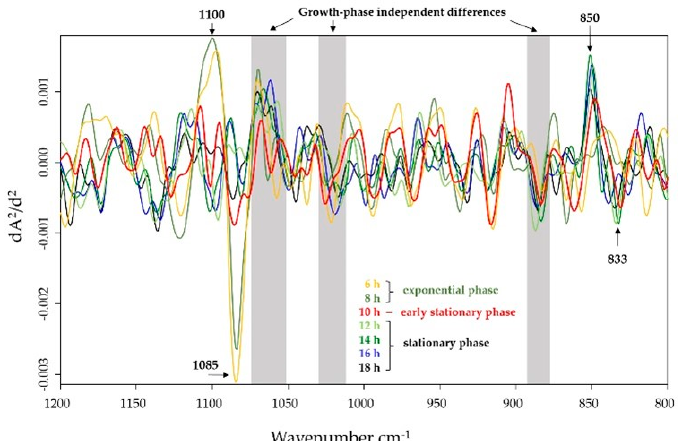
Figure 2. Differences between IN and HA surface-associated glycopolymer expression were exam- ined by FTIR spectroscopy. Alteration in the expression of S. aureus surface-associated glycopolymers of IN and HA was monitored between 6 and 18 h by 2 h intervals. Spectral comparison of bacteria at different time points was performed using the polysaccharide spectral region (1200–800 cm − 1 ), dominated by vibrations of various carbohydrates and their specific types of glycosidic linkages. Subtraction spectra were generated from the second derivative, vector-normalised, average S. aureus FTIR spectra. Spectra from the HA isolate were subtracted from that of the IN isolate.